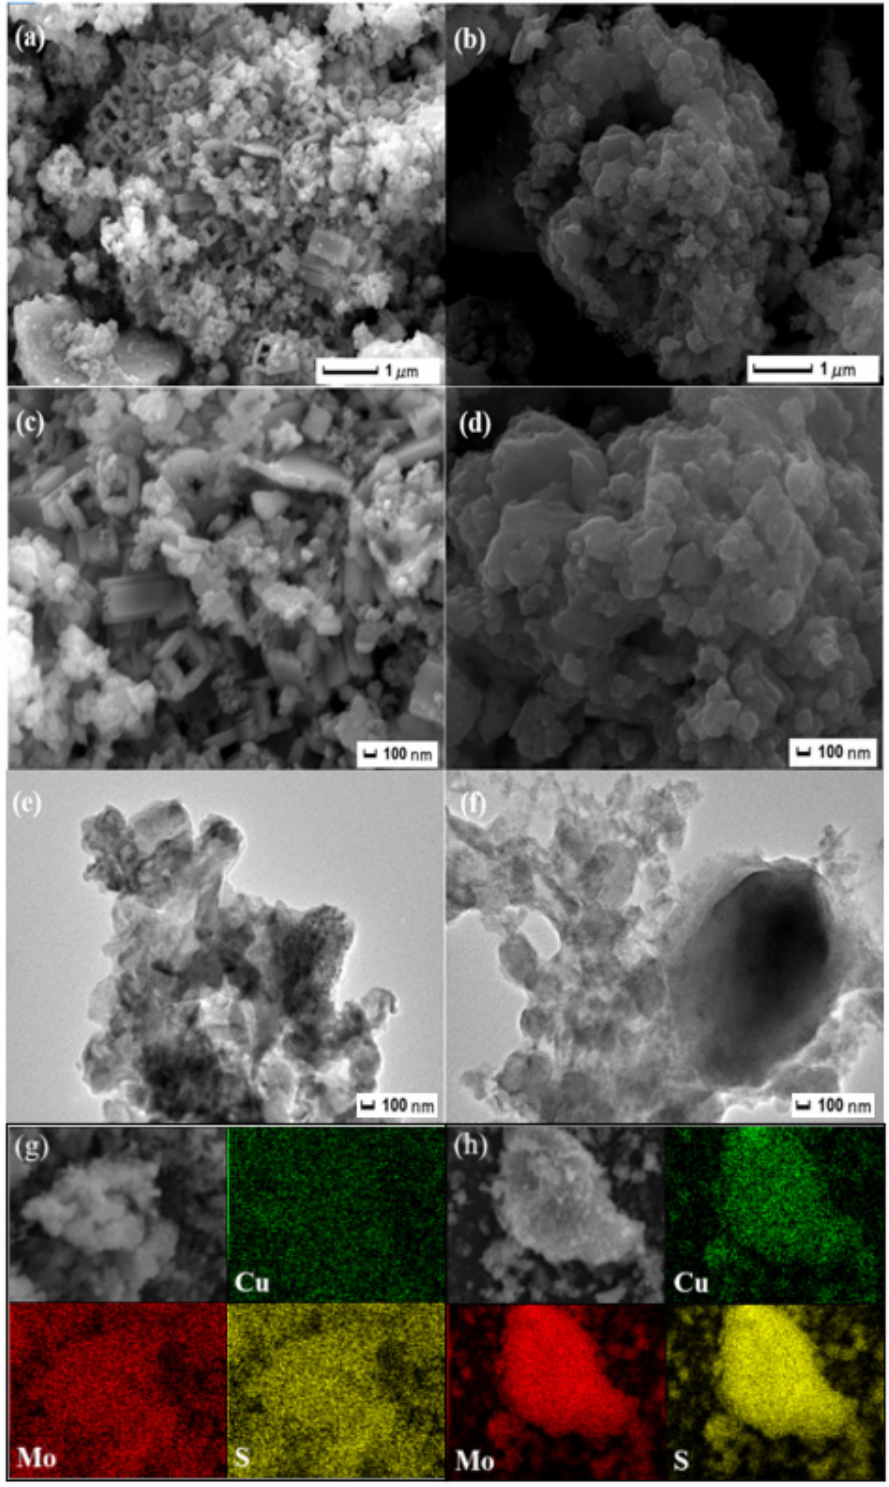
Figure 2. ( a , c ) SEM, ( e ) TEM, and ( g ) elemental mapping images of Cu 2 MoS 4 ; ( b , d ) SEM, ( f ) TEM, and ( h ) elemental mapping images of FeMoS 4 .